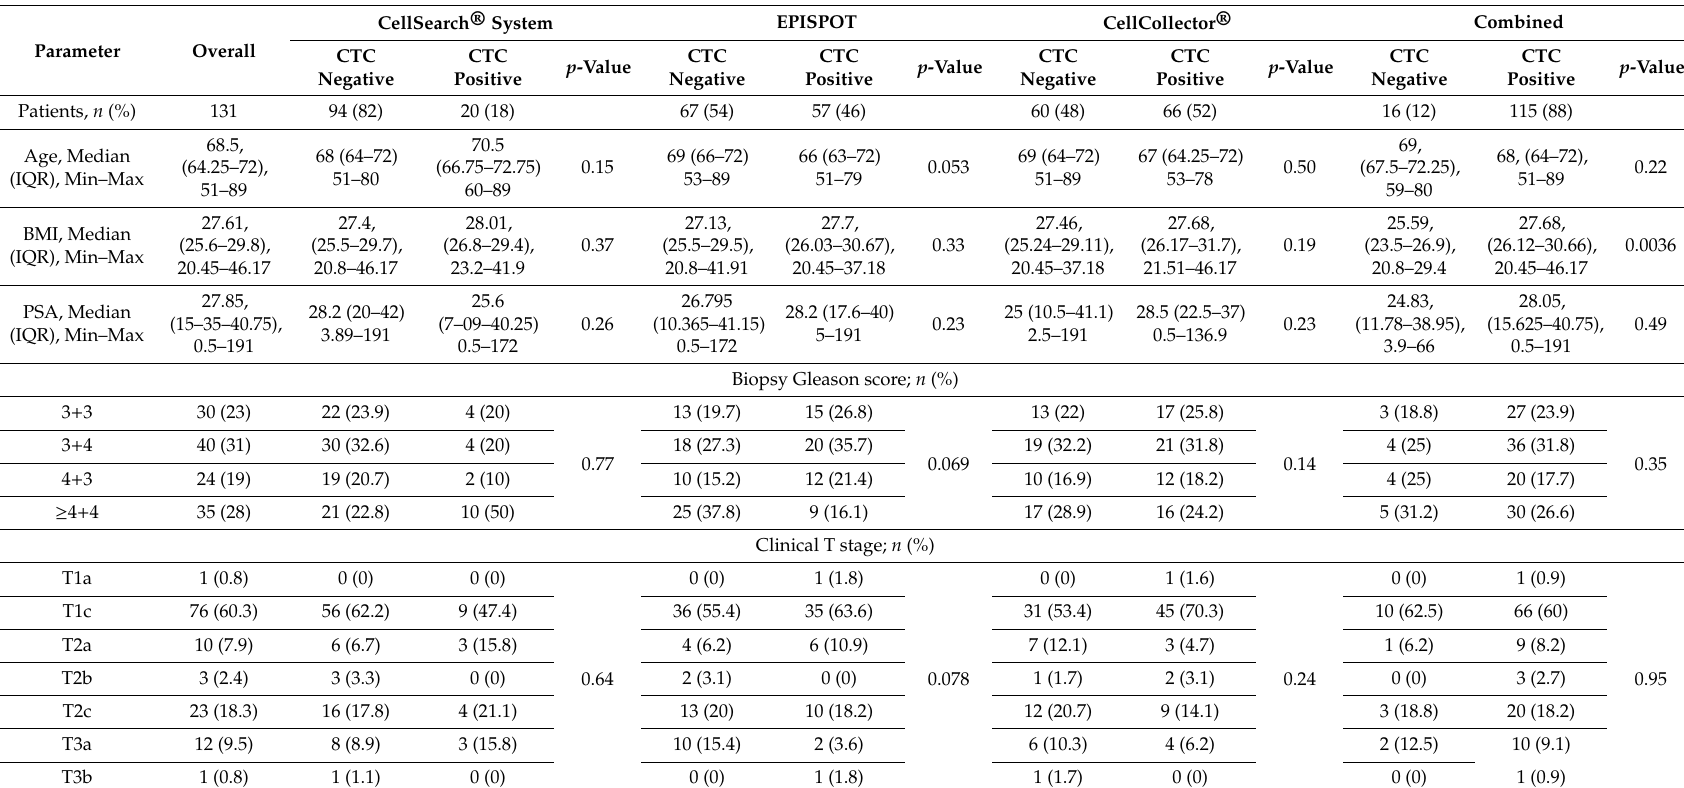
Table 1. Clinical characteristics of the